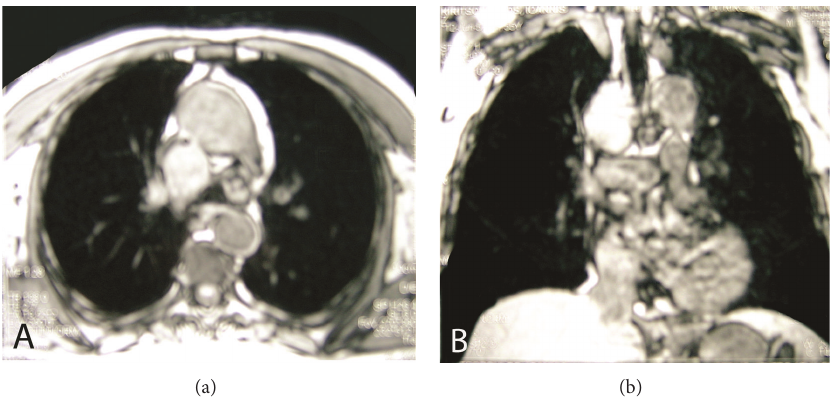
Figure 2: Axial (a) and coronal (b) chest MR images demonstrate right paratracheal lymph node